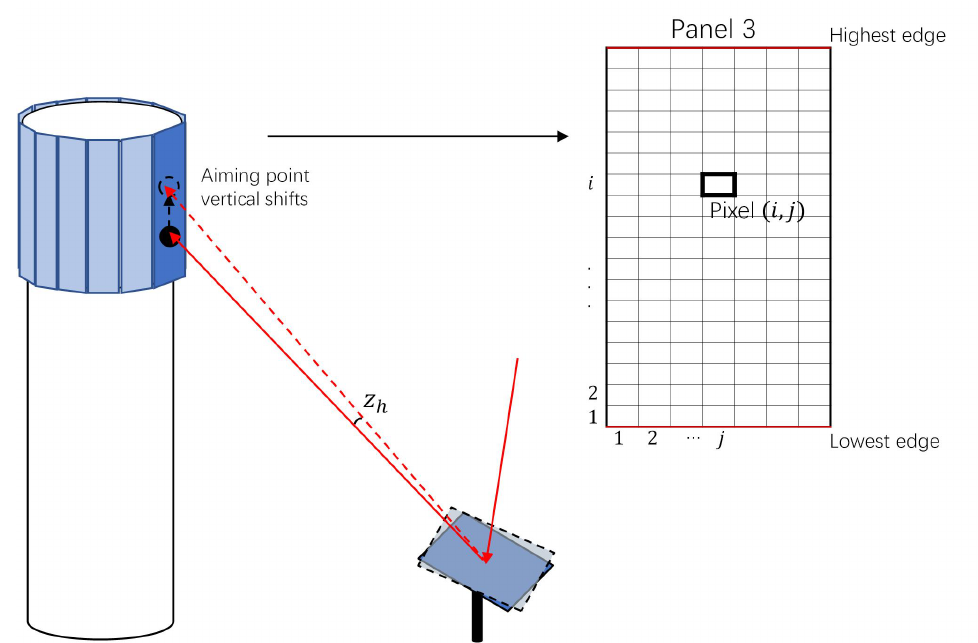
Figure 2. A brief description of the heliostat aiming